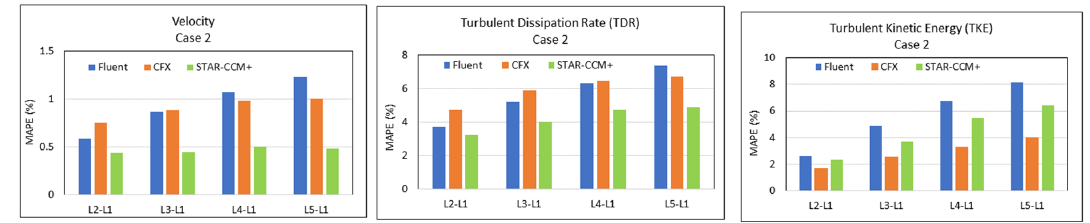
Figure 12. Case 2: Comparison of the mean vertical variations of the absolute percentage error / di ff erences (MAPEs) for each parameter ( u , TKE, and TDR) using the three